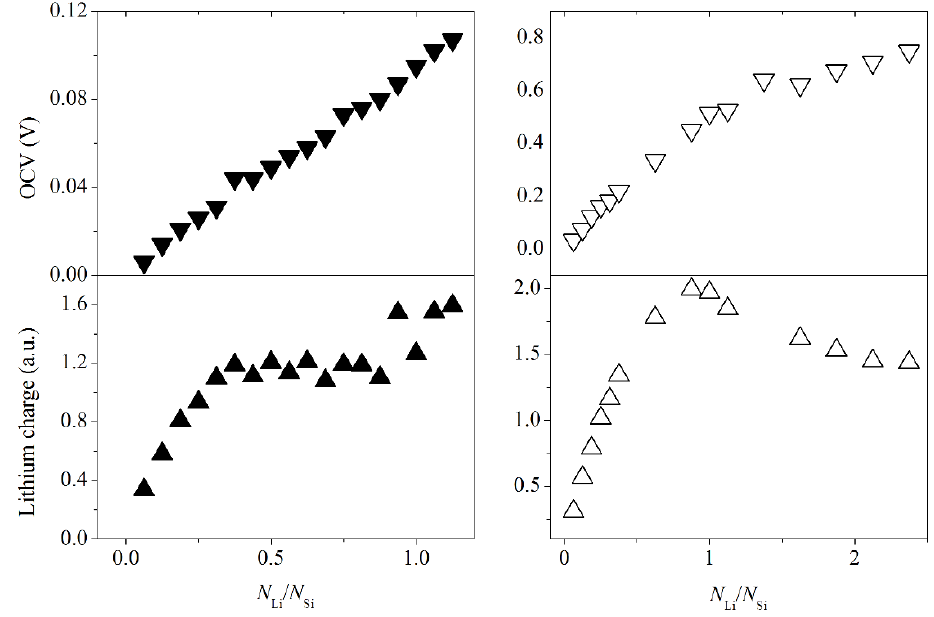
Figure 5. The open-circuit voltage and the total charge of lithium in the “silicene on bilayer graphene” system and for a free-standing silicene sheet.